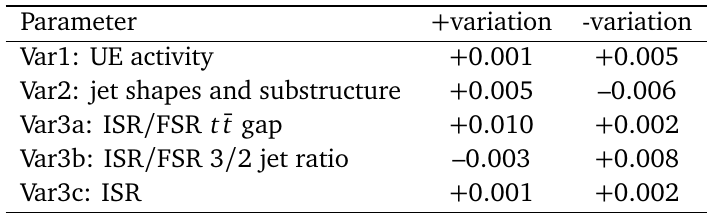
Table 4: Variations in the AuC for different Pythia